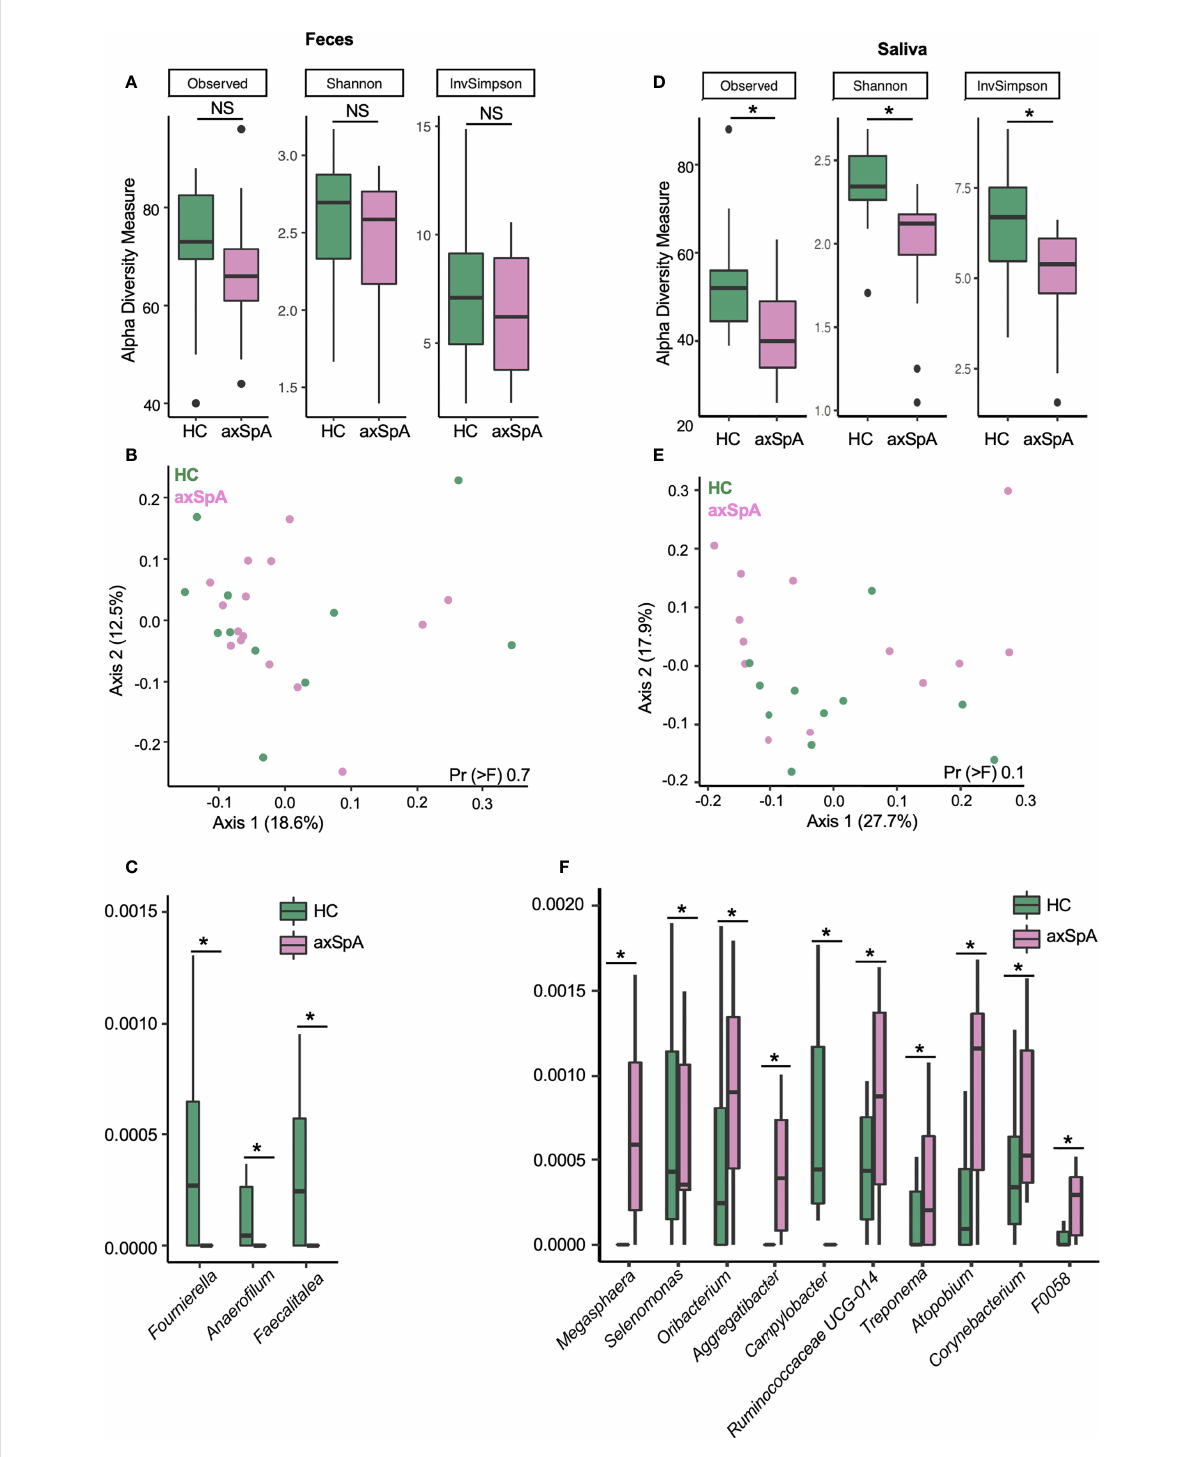
FIGURE 1 16S sequencing of fecal and salivary samples in axSpA patients and HCs at the genus level. (A – C) represent fecal samples and (D – F) are salivary samples from axSpA patients (pink) and HC (green). Alpha diversity plots with Observed, Shannon and Inverse Simpson (InvSimpson) indices for (A) fecal and (D) salivary samples. Microbial composition of (B) fecal and (E) salivary samples analyzed using the unweighted Unifrac distance represented as a principal coordinate analysis (PCoA) plot. Relative abundance of genus level microbes in (C) fecal and (F) salivary samples that are different between axSpA patients and HC. * P <0.05; NS not signi fi